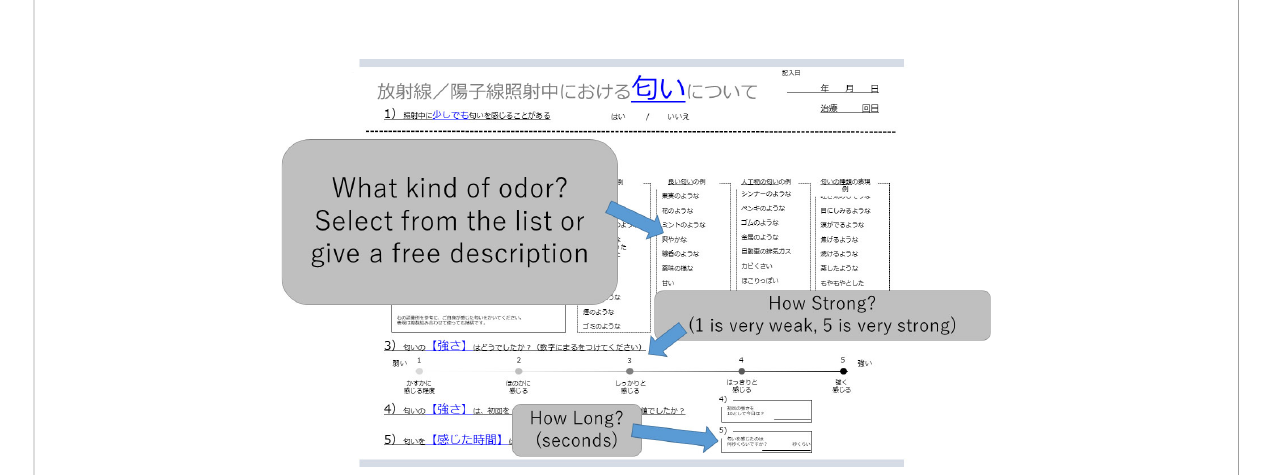
FIGURE 2 Checklist for evaluation of odor during irradiation. Patients fi rst indicate if they detected an odor. If this answer is “ yes ” , the kind of odor (selected from a list or provided as a free description), intensity (1 to 5), and time (seconds) are entered by the